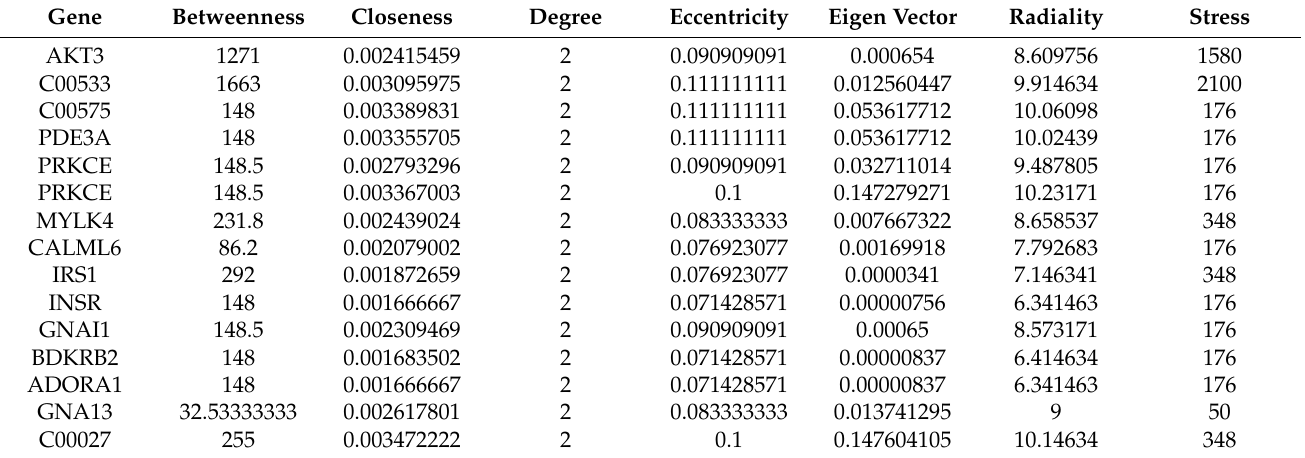
score of 67.90, 36 amino acids, and a probability score of 0.990. The second binding pocket (red color) consists of a pocket score of 1.23, seven amino acids, and a probability score of 0.012. Finally, the third binding pocket (green color) had the smallest pocket score of 1.15,